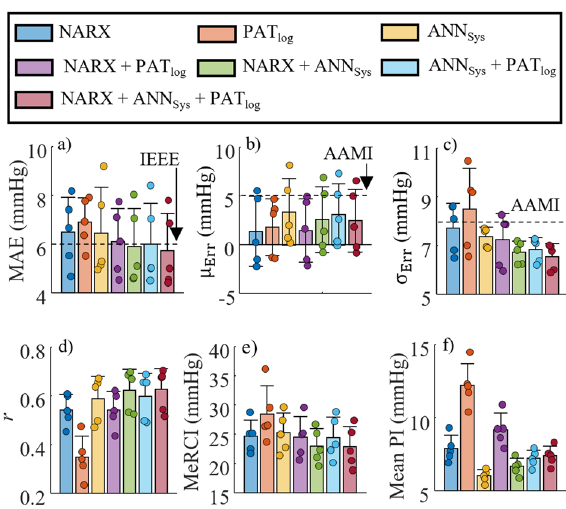
Figure 3. Comparison of ( a ) mean absolute error, ( b ) mean error, ( c ) standard deviation of the error, ( d ) Pearson correlation coefficient between different model estimates and the BP measurements, ( e ) MeRCI score, and ( f ) mean estimated prediction interval. Bars represent the mean of all subjects and the error bars show ± SD. Each data point represents one participant. The IEEE cuffless wearable and the AAMI standard limits are also shown via horizontal dashed lines in subplots ( a ), and ( b,c ),